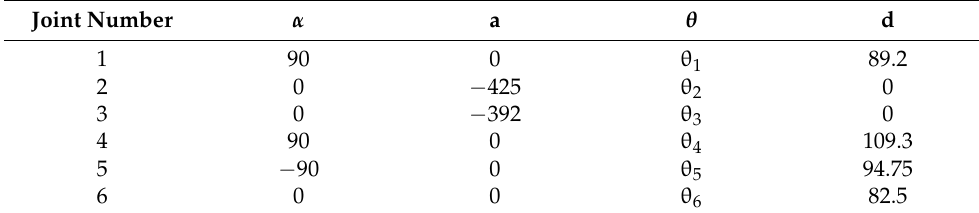
Table 1. DH parameters of the main robot